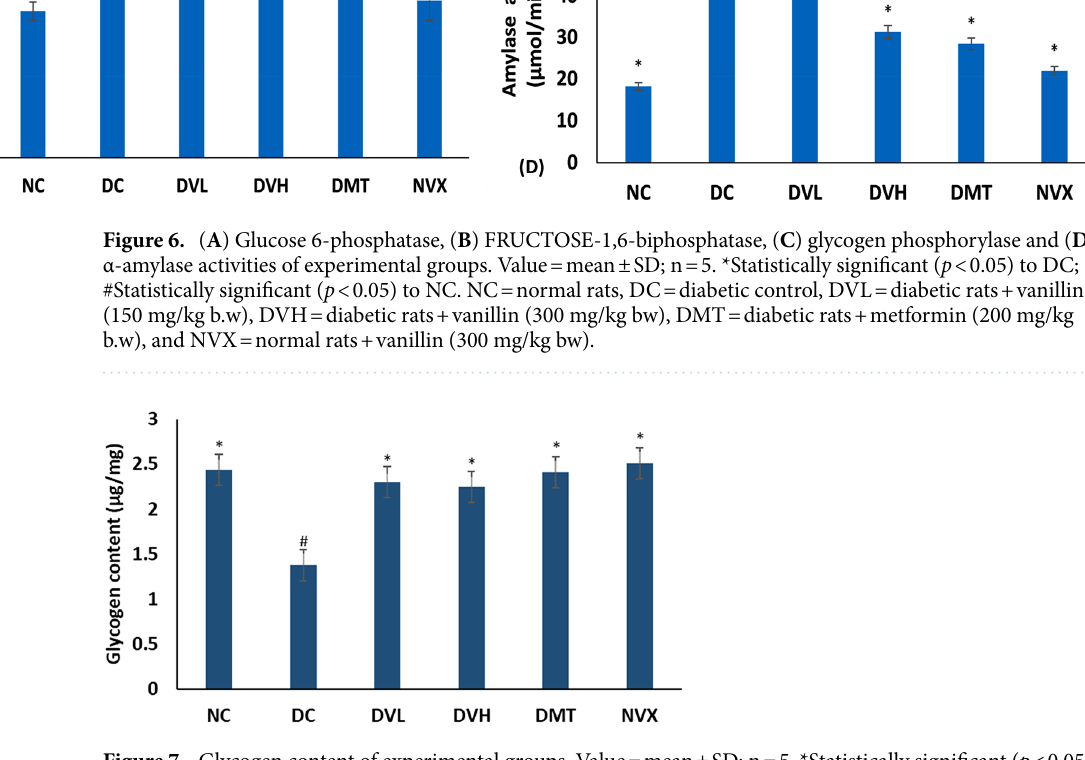
Figure 7. Glycogen content of experimental groups. Value = mean ± SD; n = 5. *Statistically significant ( p < 0.05) to DC; #Statistically significant ( p < 0.05) to NC. NC = normal rats, DC = diabetic control, DVL = diabetic rats + vanillin (150 mg/kg b.w), DVH = diabetic rats + vanillin (300 mg/kg bw), DMT = diabetic rats + metformin (200 mg/kg b.w), and NVX = normal rats + vanillin (300 mg/kg